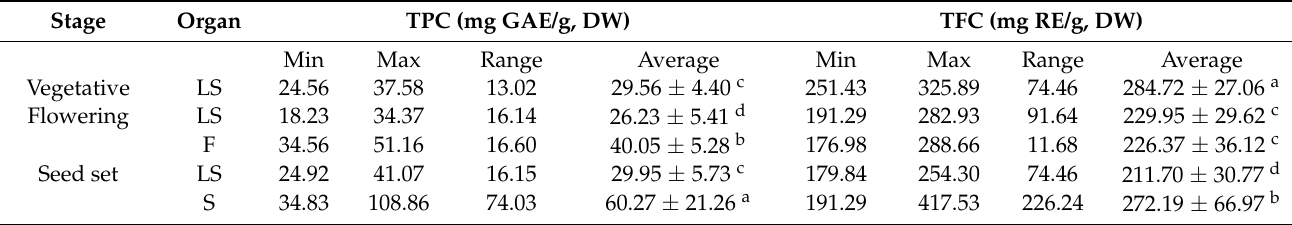
Table 1. Total phenolic and flavonoid contents of different organs of eight accessions CG in the vegetative, flowering, and seed set